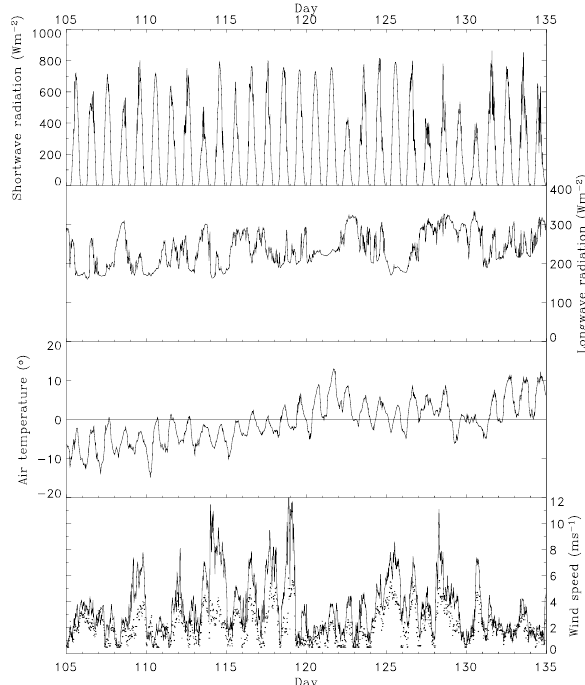
Fig. 4. As Fig. 3, but for 14 April to 13 May